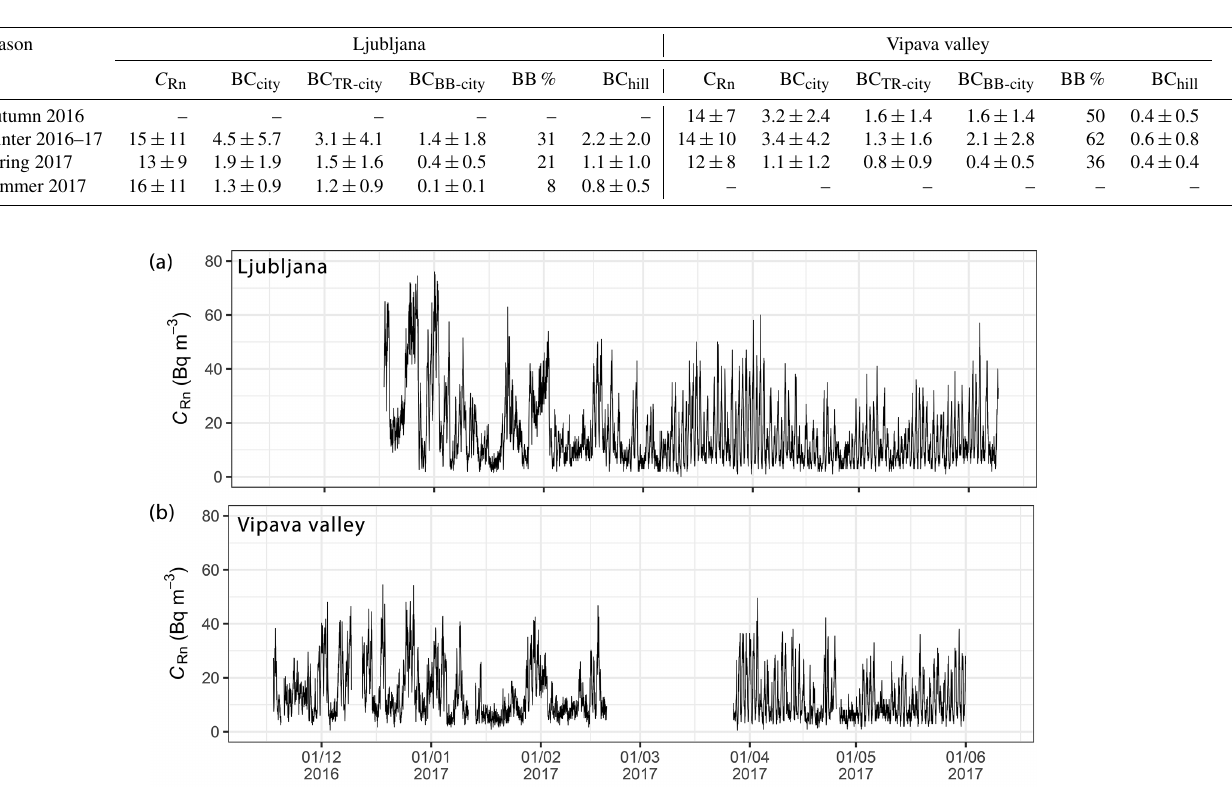
Figure 2. Time series of radon activity concentration ( C Rn ) measured in Ljubljana and (a) and in Ajdovšˇcina (at the floor of Vipava